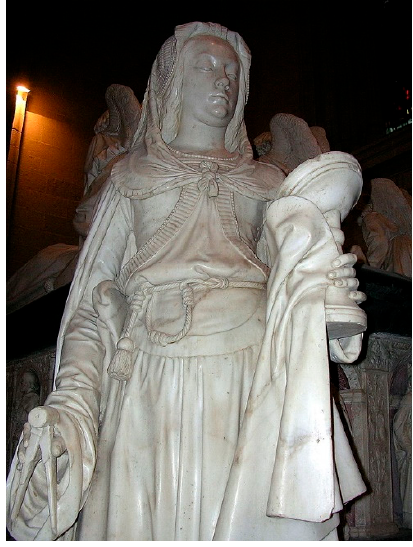
Figure 1. Front view of Colombe’s Prudence. 8